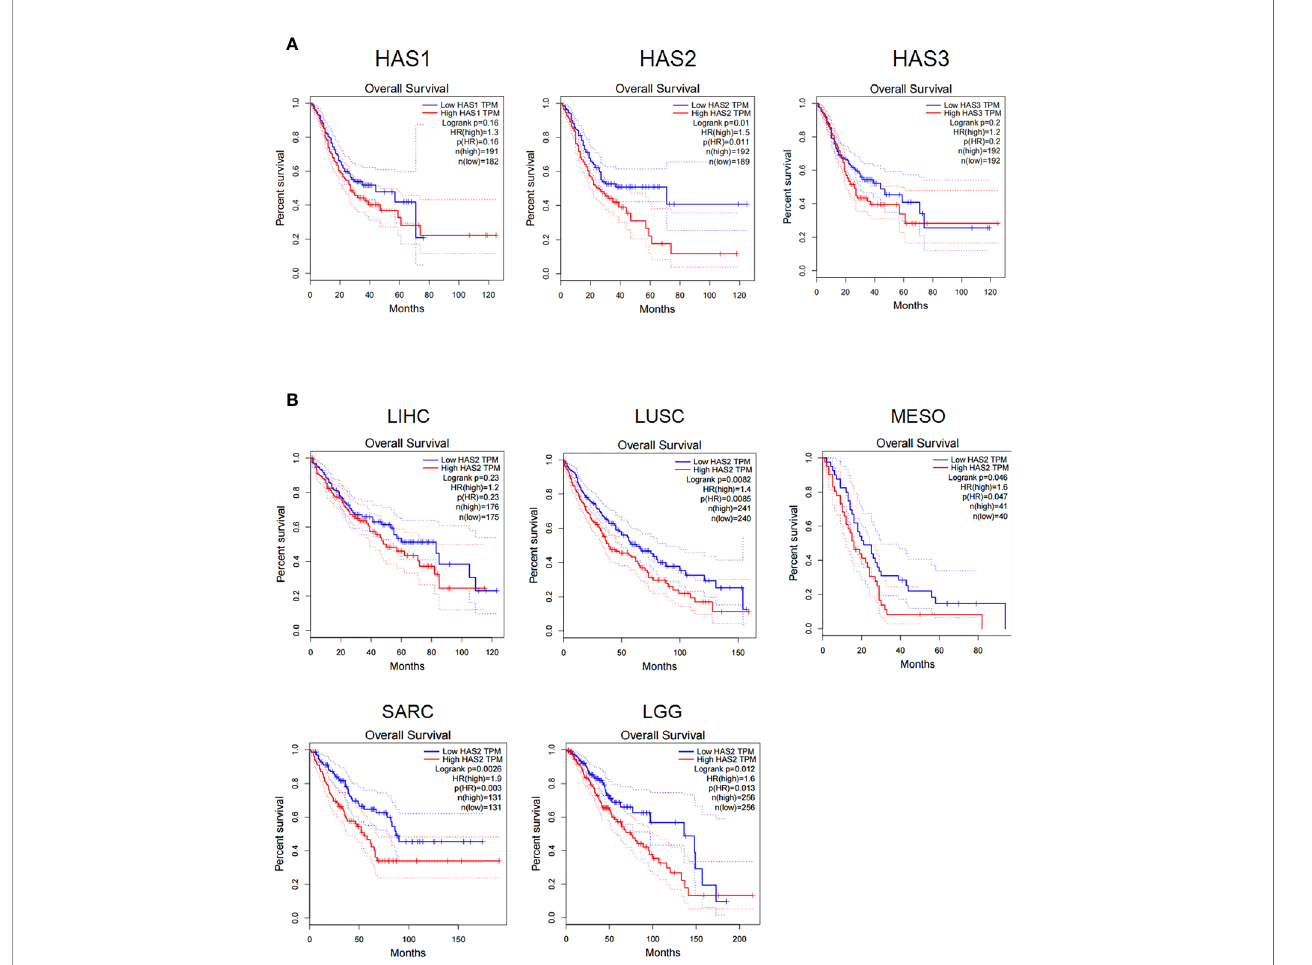
FIGURE 1 | The expression of HA synthase (HAS) is negatively correlated with the disease prognosis of cancer patients. (A) Data analysis of the correlations of hyaluronic acid synthase expression (HAS1, HAS2, and HAS3) with patients survival in STAD patients. (B) Analysis for the correlations of the expression of hyaluronic acid synthase 2 (HAS2) with patient survival. LIHC, liver hepatocellular carcinoma; LUSC, lung squamous cell carcinoma; MESO, mesothelioma; SARC, sarcoma; LGG, low-grade glioma. The results were compared with Log-rank test with 95% Con fi dence Interval, Median survival was used as group cutoff with 50% high group and 50% low